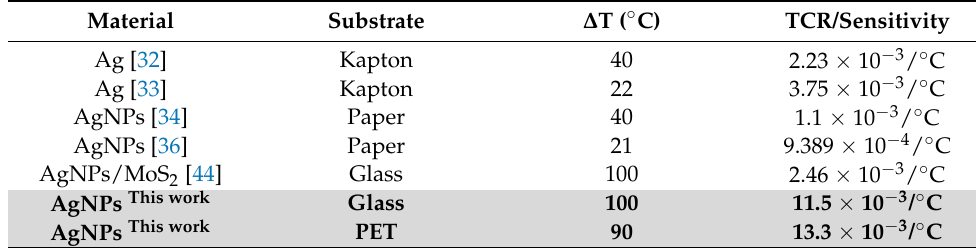
Table 4. Fabricated RTD values at different room temperatures, recorded over three months.